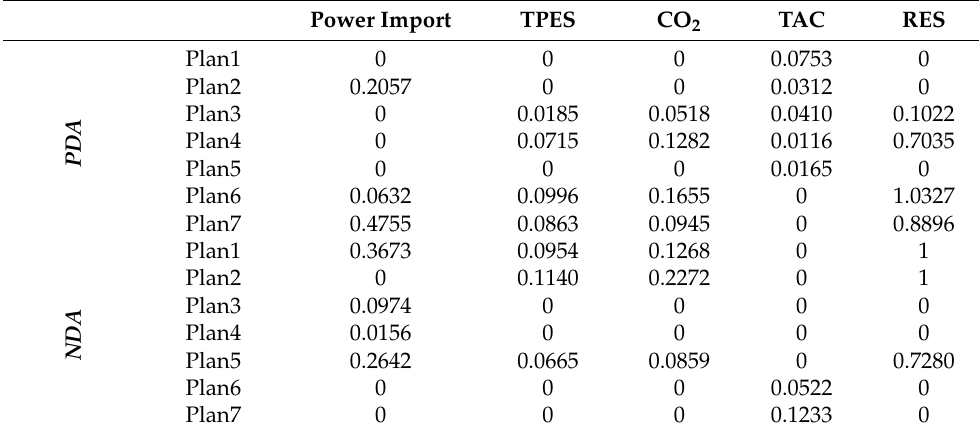
Table 7. Positive and negative distance from average solution.